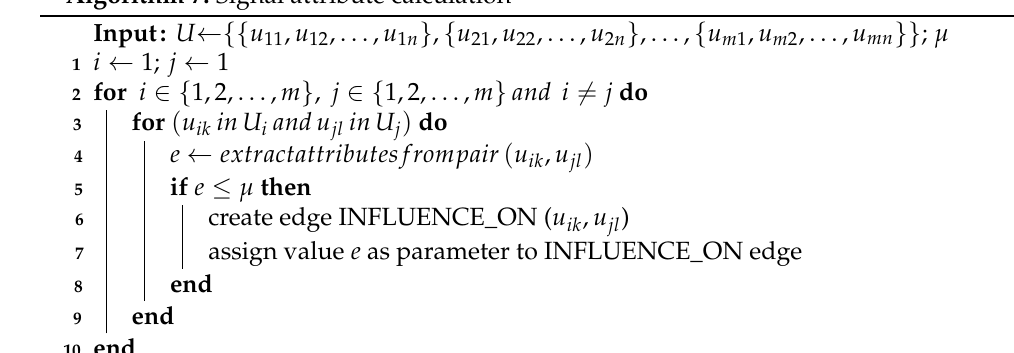
Algorithm 7: Signal attribute